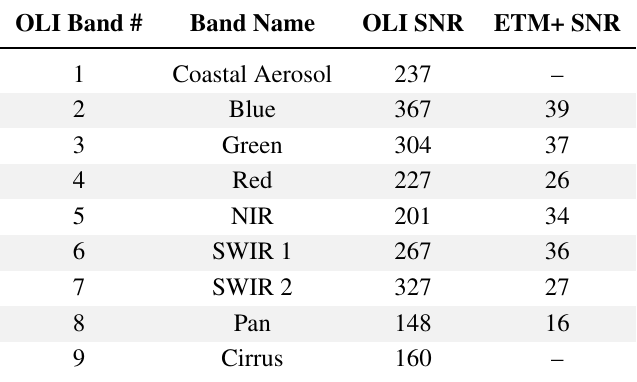
Table 4. Signal-to-noise ratios for OLI and ETM+ spectral bands at the typical spectral radiance levels shown in Table